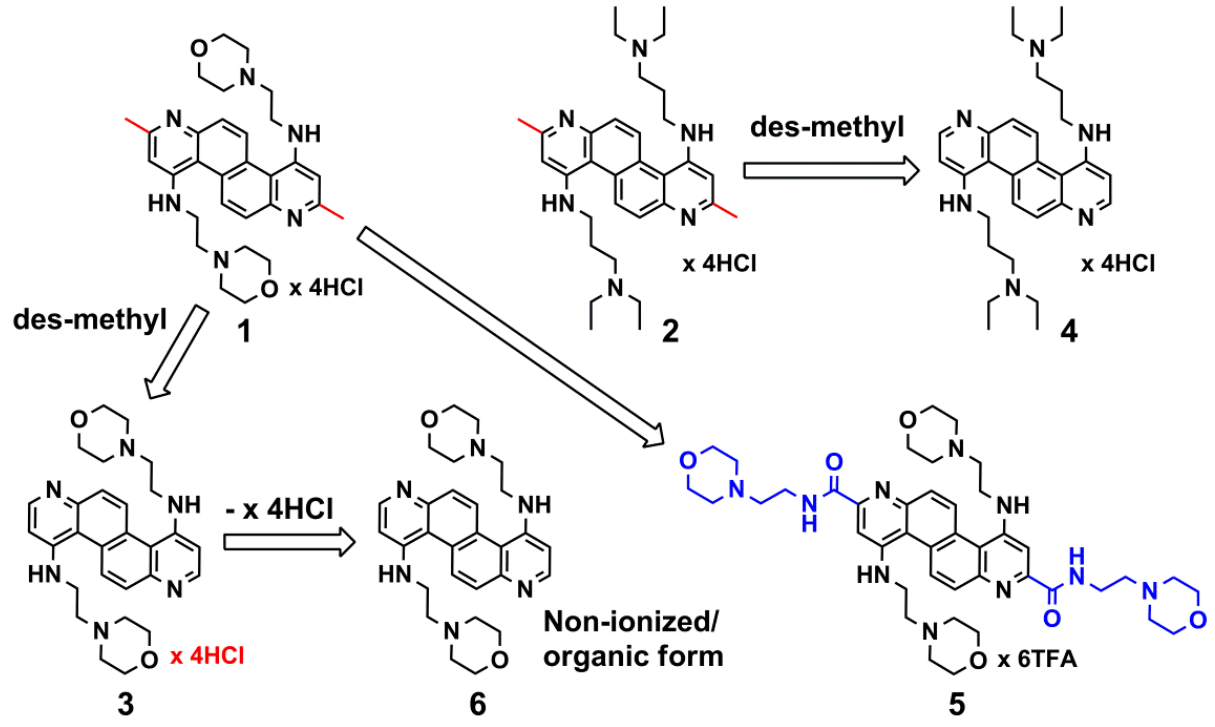
Figure 1. The chemical structures of compounds 1 – 6 . The bis-2,8-methyl substituents of parent compounds 1 and 2 are depicted in red. The term ‘des-methyl’ indicates the removal of these substituents to provide analogs 3 and 4 , respectively. For analog 5 , blue indicates the bis-2,8-amide-ethylmorpholino groups replacing the bis-2,8-methyl substituents of 1